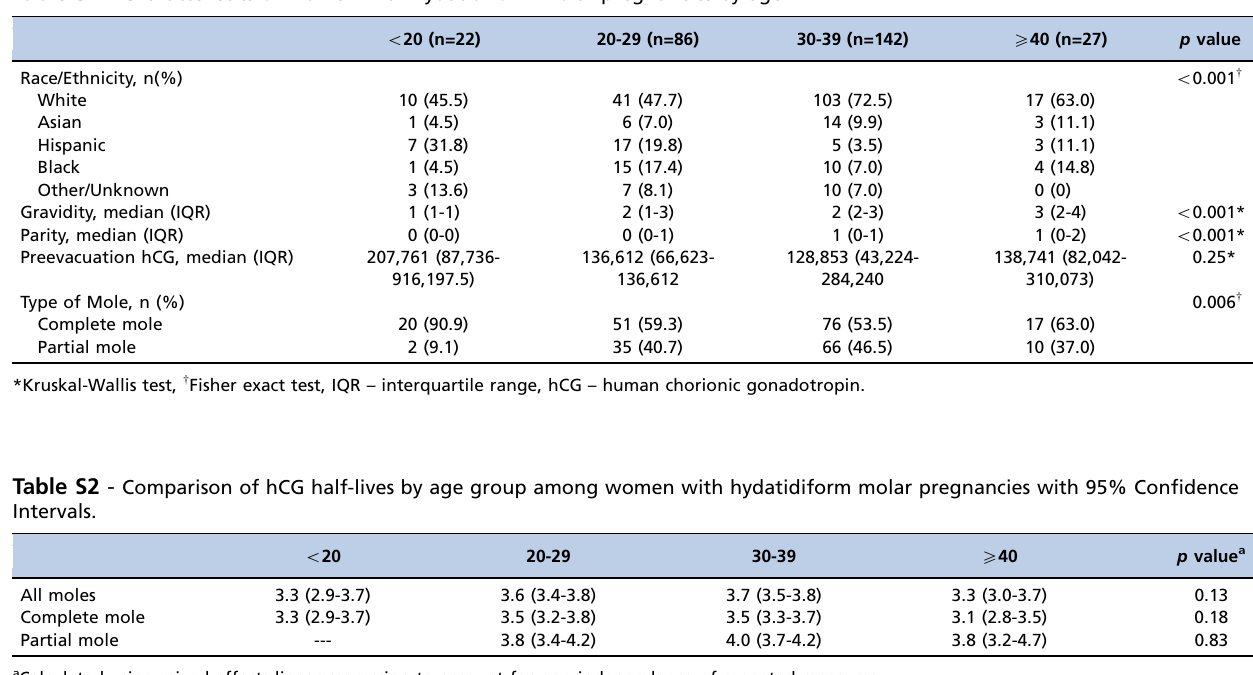
Table S1 - Characteristics of women with hydatidiform molar pregnancies by age.